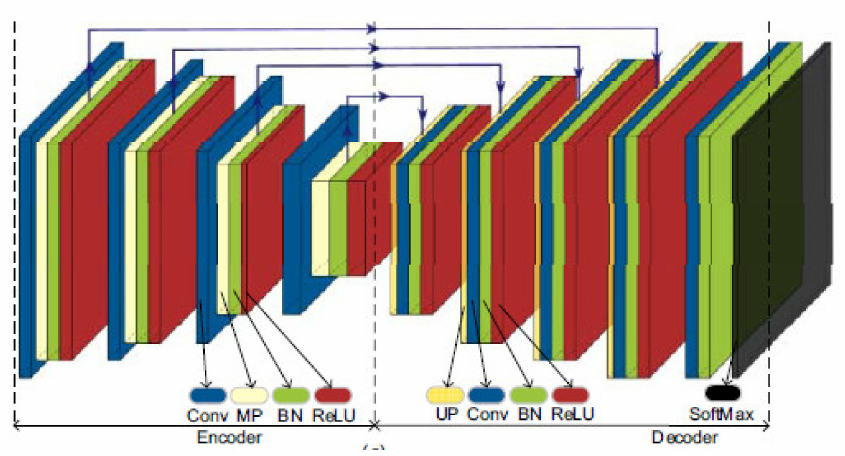
Figure 17. Encoder–decoder neural network [66] (Reprinted with permission from ref. [66]. Copyright 2021 IEEE).